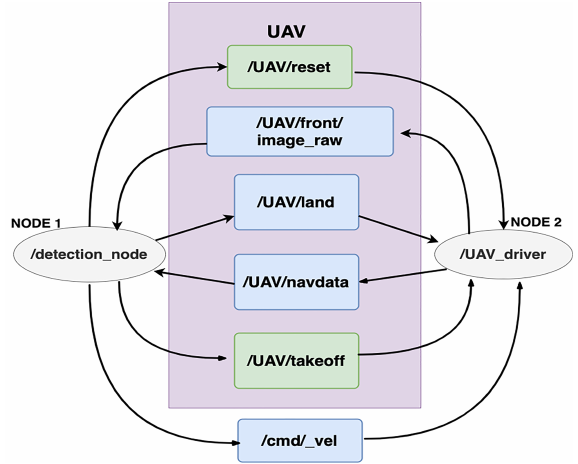
Figure 4. ROS node